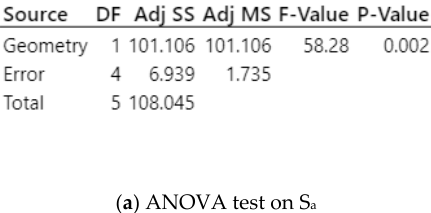
Figure 10. Main results of punch RP analysis.